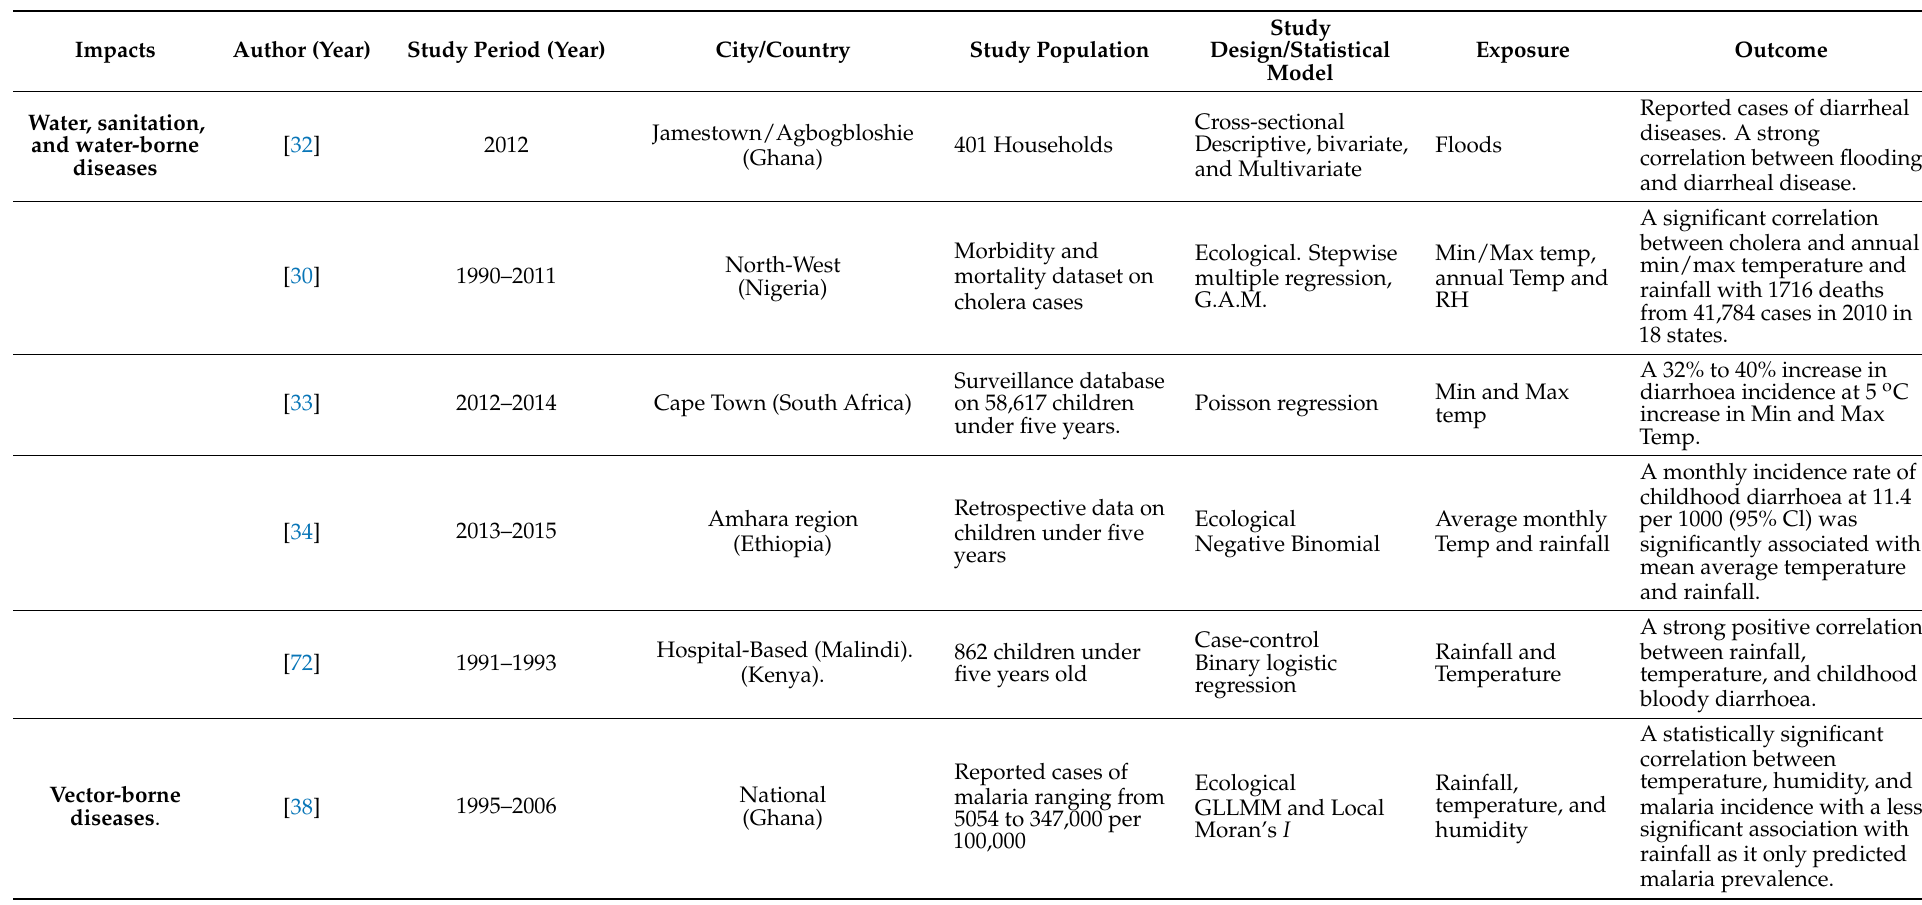
Table 1. A systematic review of the sampled countries’ literature to determine their vulnerabilities to the five significant climate change impacts: their exposure to climate drivers, the study location, and the potential resulting outcome from the exposure (see Appendix A). This was developed as a measure of the sampled country’s intensity to climate impacts on human health and the health systems’ preparedness against the impacts through the